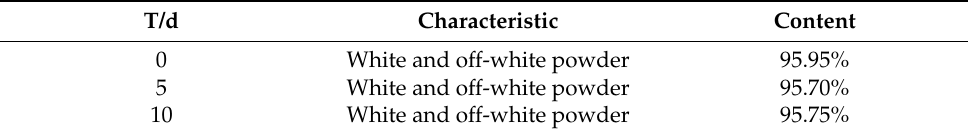
Table 10. The character and content under high temperature conditions (40 ◦ C).